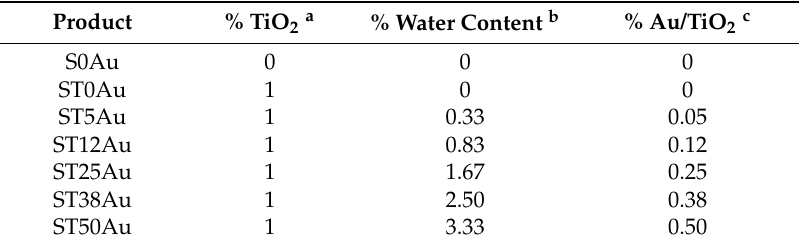
Table 1. Composition of the prepared